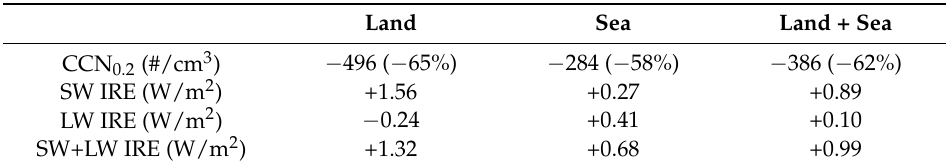
Table 8. Domain average effect of anthropogenic emission reduction. The effect on CCN and temperature is calculated as the difference between the perturbed and reference run. Indirect radiative effect (IRE) is the difference in the net radiation flux (down-up) at surface between sensitivity and perturbed